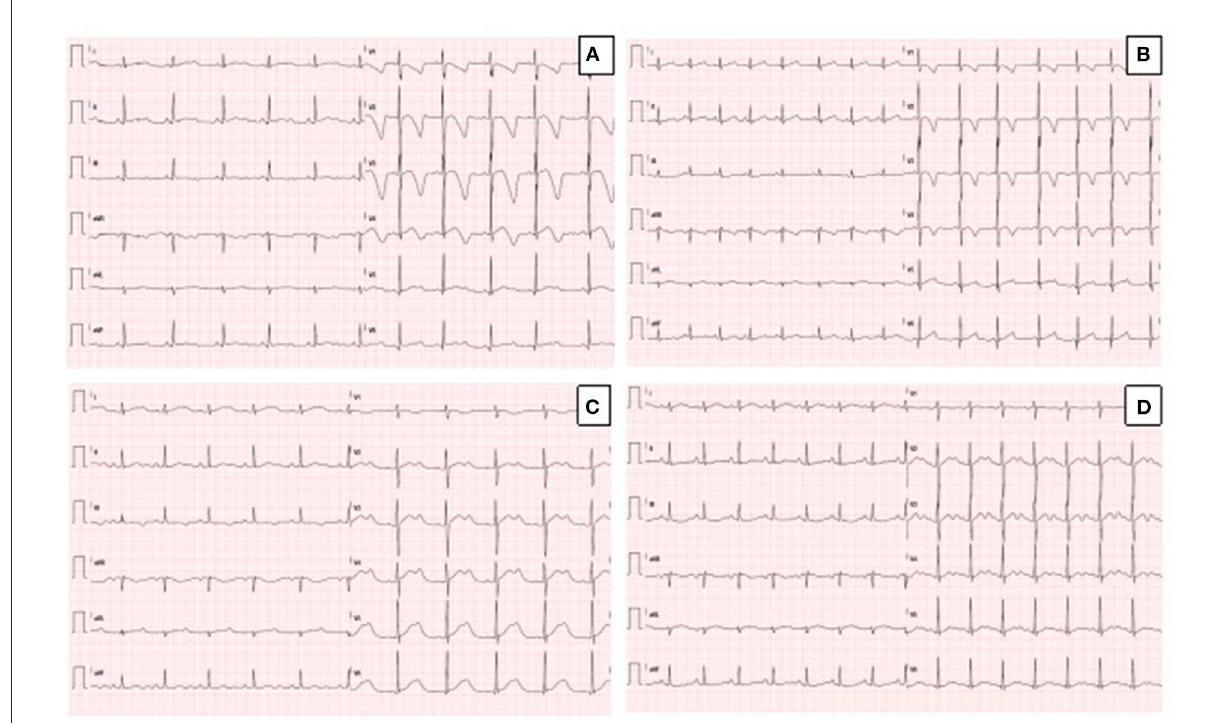
FIGURE1 (A) Resting ECG in the proband, showing sinus rhythm, QTc prolongation (567 msec) and deep T wave inversion in anterior leads. (B) Resting ECG in the sister of the proband, showing sinus rhythm, normal QTc (442 msec) and T wave inversion in anterior leads. (C) Resting ECG in the father of the proband during mild hypokalemia (K + 3.3 mEq/L), showing sinus rhythm, prolongation of QTc (614 msec) and biphasic T-waves. (D) Resting ECG in the father of the proband during normokalaemia (K + 4.1 mEq/L), showing sinus rhythm, prolongation of QTc (550 msec), and biphasic T-waves (pseudo-U